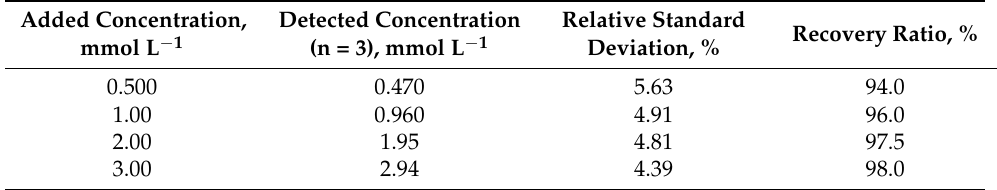
Table 1. Recovery of glucose in human serum using an electrochemical biosensor based on GOx/DGNs/GR electrode. ( n —number of measurements)